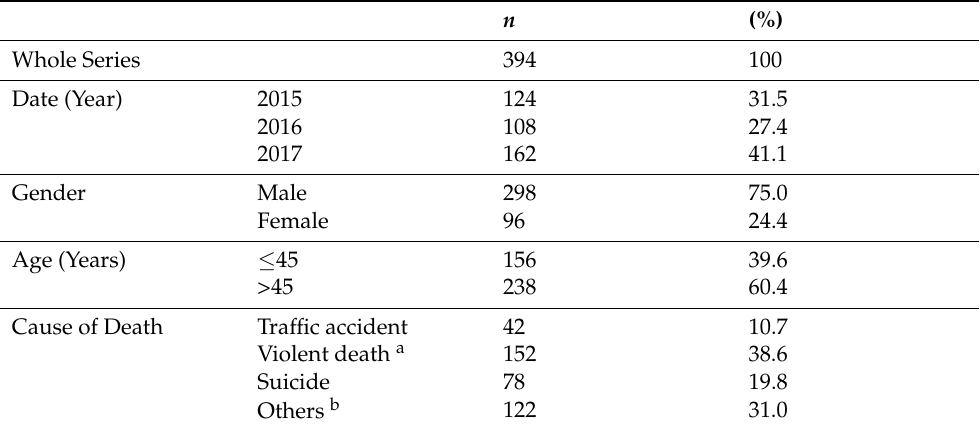
Table 1. Description of subjects by sociodemographic characteristics and forensic